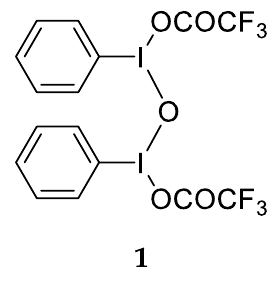
Figure 1. PIDA, PIFA, and the μ -oxo-bridged dimer 1.